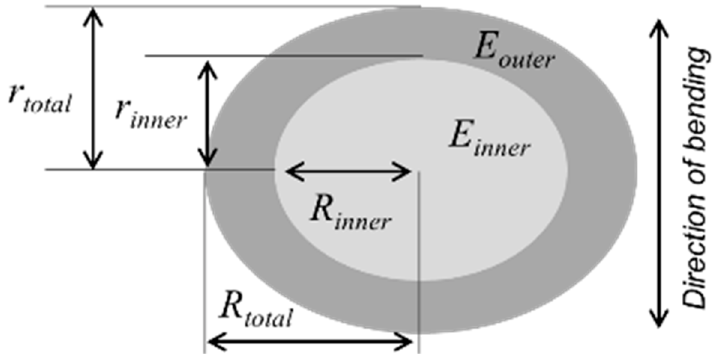
Figure 3. Geometry of double-layered model. E outer = the bending elasticity of the outer layer, E inner = the bending elasticity of the inner layer (surface-removed hair), R total = the hair radius in the major axis of the whole hair, R inner = the hair radius in the major axis of surface-removed hair, r total = the hair radius in the minor axis of the whole hair, r inner = the hair radius in the minor axis of the surface-removed hair